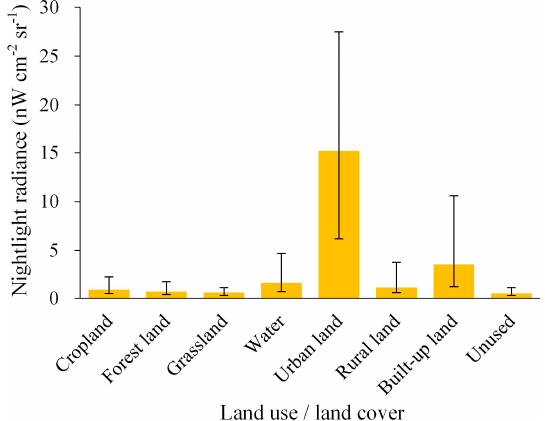
Figure 4. Statistical summary of the pixel-level VIIRS nighttime radiances for eight types of land use/land cover across China in 2015. Here, the lower quartile (25th percentile), median, and upper quartile (75th percentile) are presented.